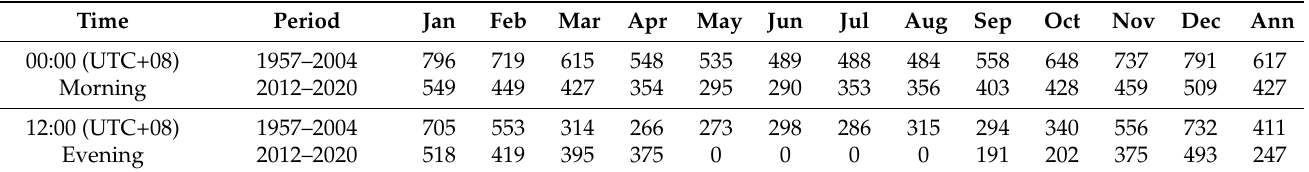
Table 5. Recent changes in the monthly average thickness (m) of the near-surface temperature inversion over Ulaanbaatar city.